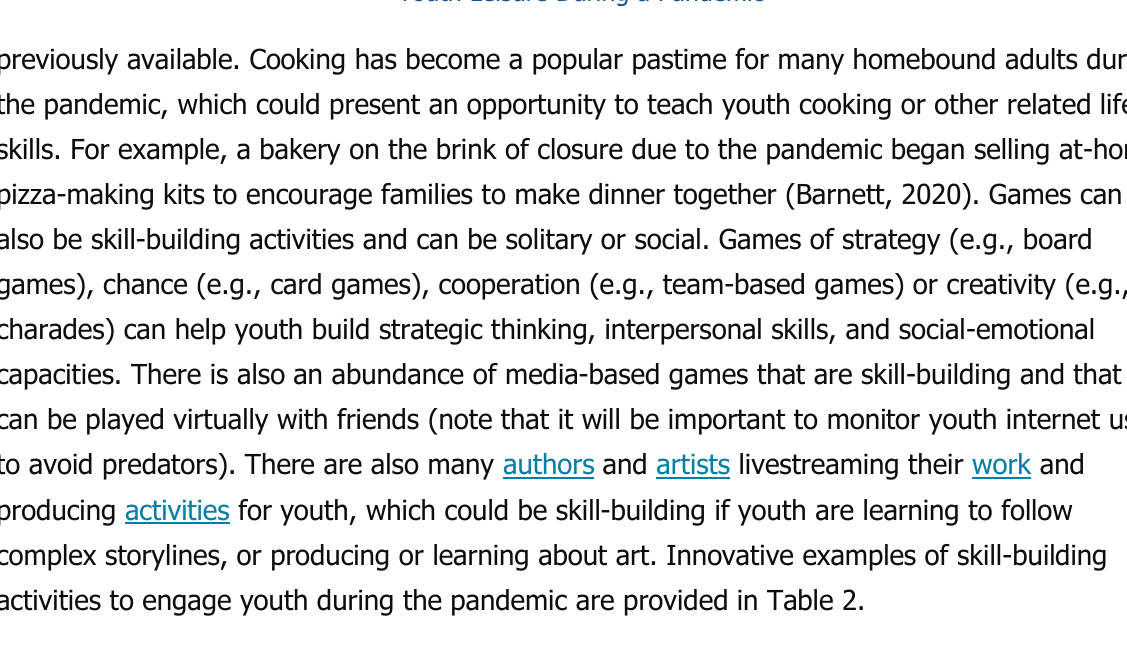
Table 2. Supporting Youth Skill-Building During the COVID-19 Pandemic